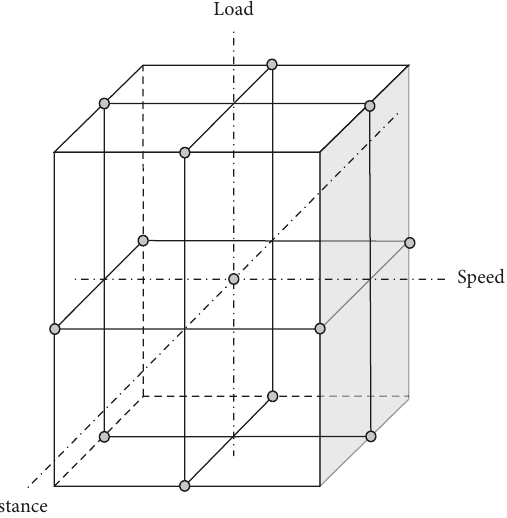
Figure 2: Box–Behnken